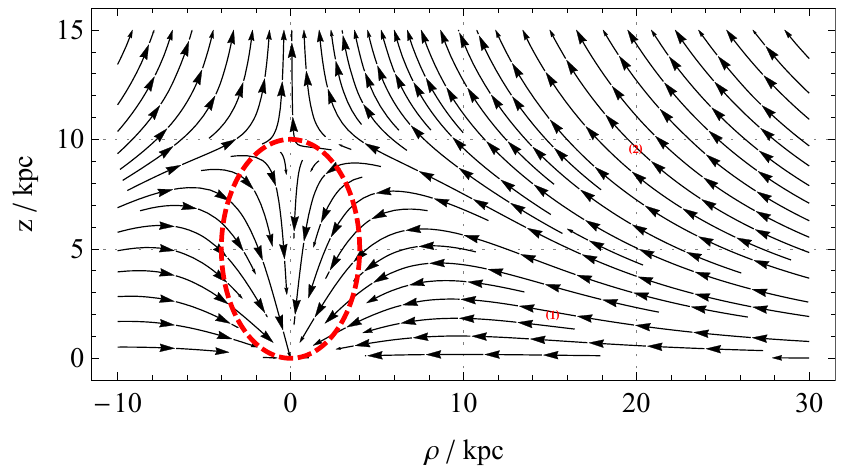
Figure 2. The streamlines of the combined acceleration acting on off-galactic-plane particles, due to the galactic core mass M and the EWM parametrized by κ . The values of these parameters are taken to approximate the Milky Way, with κ = 5.3 × 10 − 10 kpc − 2 being the average of the three galaxies from the last section (in the same cluster as the Milky Way) and M = 2 × 10 10 M (cid:12) , since the overall mass of the Milky Way is about half of that of M31. The red dashed circle signifies the boundary of the Fermi bubble. The coincidence between the bubble and separatrix heights may be accidental, or alternatively, the hardness of the X-ray emissions (Loop I, residing further out, has a softer spectrum) may depend on whether the EWM-driven ambient and active galactic nucleus (AGN)/starburst-driven burst flows are counter-streaming (relevant for shock wave